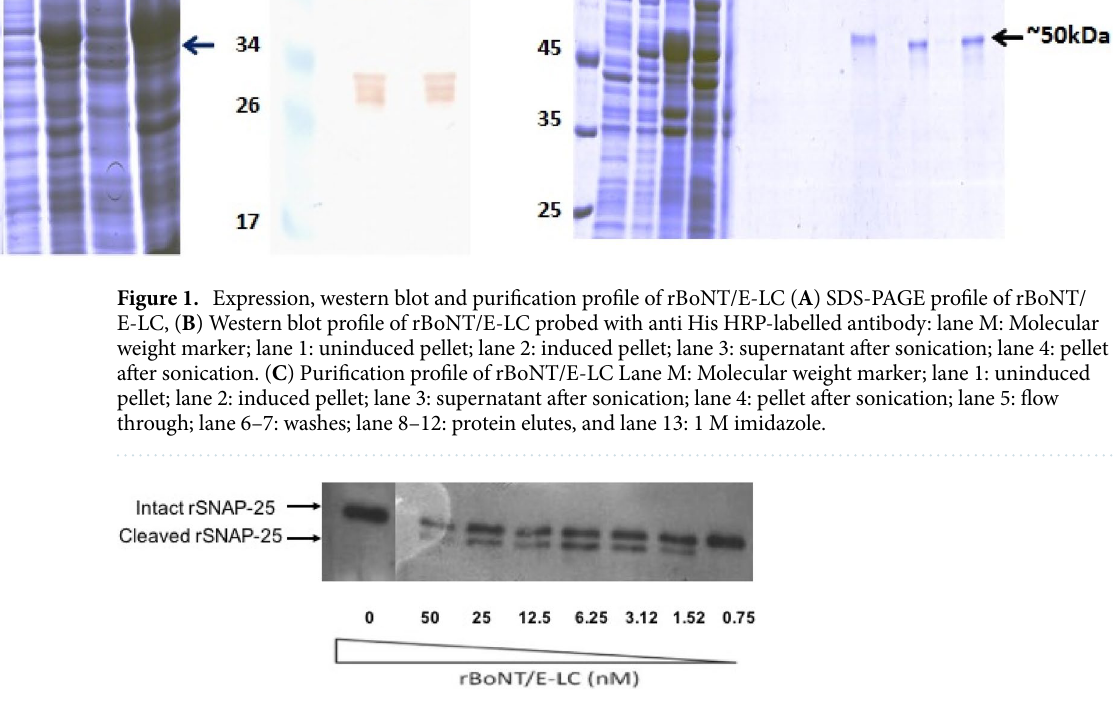
Figure 2. Endopeptidase assay for biological activity of rBoNT/E-LC on rSNAP-25. This assay was performed with fixed concentration of rSNAP-25 (2.5 mM) and incubated with serially diluted concentration of rBoNT/ E-LC at 37 °C. Samples were withdrawn after 15 min of incubation, reaction was stopped by adding sample lysis buffer. The immunoblot assay depicts the extent of rSNAP-25 cleavage in rSNAP-25 alone (control). The cleaved rSNAP-25 was analysed by densitometry. The graph illustrates the cleavage activity of purified protein was observed even at the lowest concentration of light chain. Lane 1: rSNAP-25, lane 2–7: rSNAP-25 reaction proceeded with rBoNT/E-LC serially diluted from 100